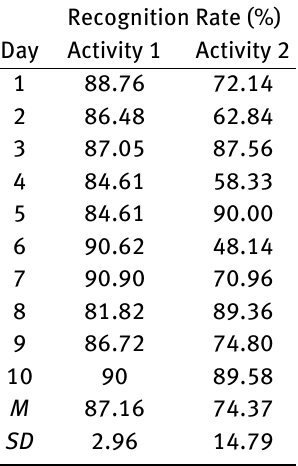
Table 4: Leave-one-out methodology (CASAS dataset).